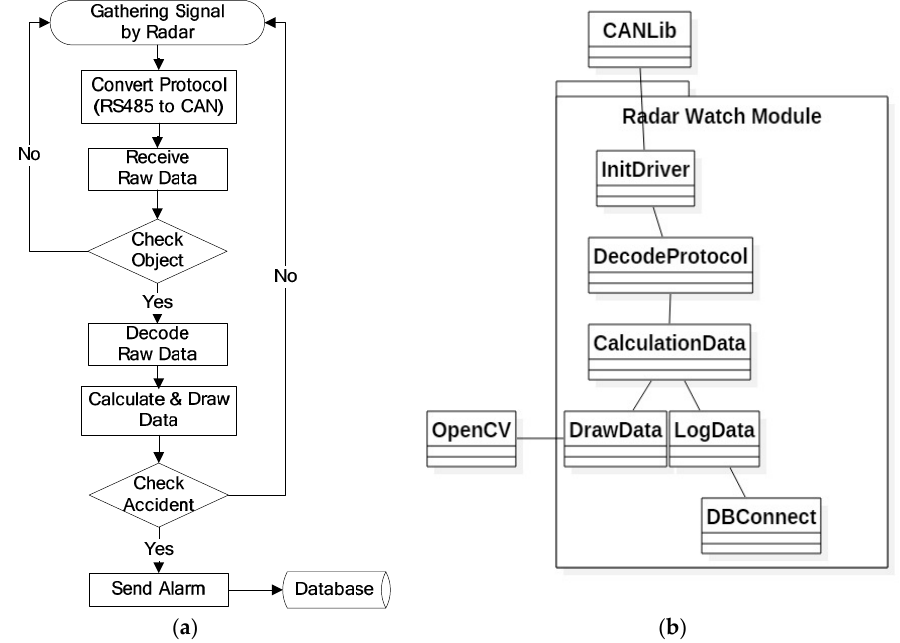
Figure 2. Overall architecture of the Road Watch Module (RWM): ( a ) Operation procedure; ( b ) module